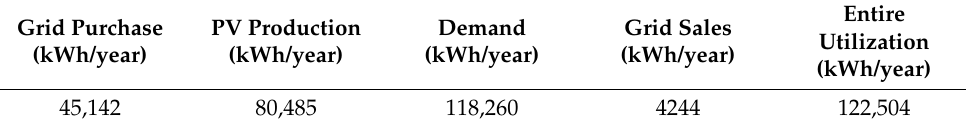
Figure 10. The monthly average electric production for grid/PV systems. Table 7. Annual electricity generation and utilization of grid/PV systems in the site.